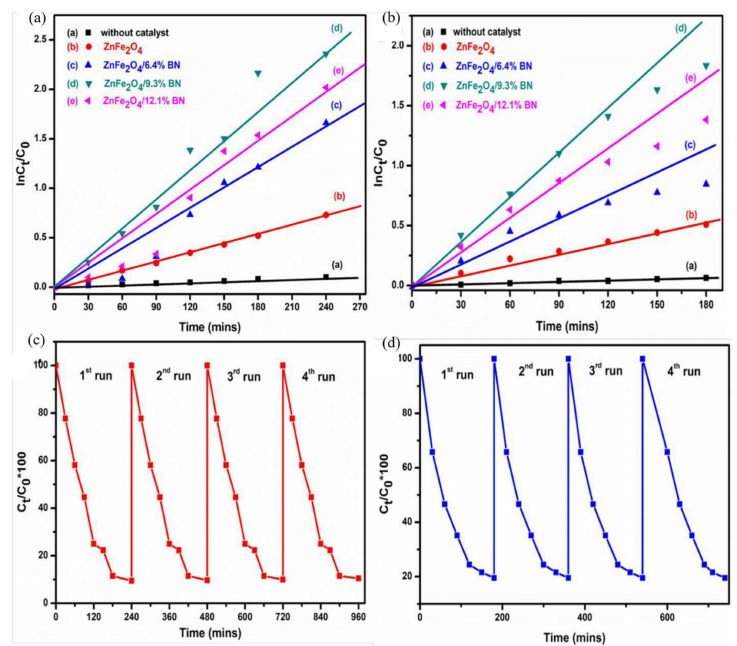
Figure 17. The kinetic plots in the photodegradation of ( a ) CR and ( b ) TC by the as-synthesized catalysts; photo-stability of the ZnFe 2 O 4 /9.3% BN composite catalyst in the degradation of ( c ) CR and ( d ) TC [120] (reprinted with permission from [120] Erusappan et al.,